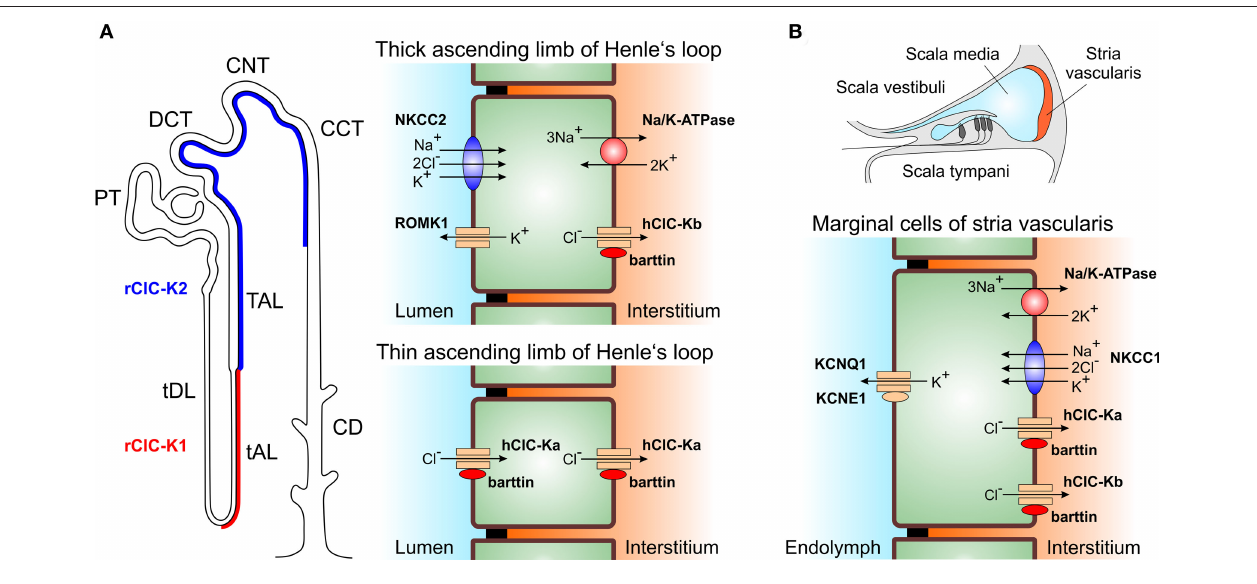
Figure 1 | Physiological functions of ClC-K channels. (A) Major expression sites of ClC-K channels in the nephron. ClC-Ka/ClC-K1 permits passive transepithelial transport of chloride in the thin ascending limb of Henle. ClC-Kb/ClC-K2 is necessary for secondary-active sodium chloride reabsorption in the outer medulla and cortical region of the kidney. (PT, proximal tubule; tDL, thin descending limb of Henle’s loop; tAL, thin